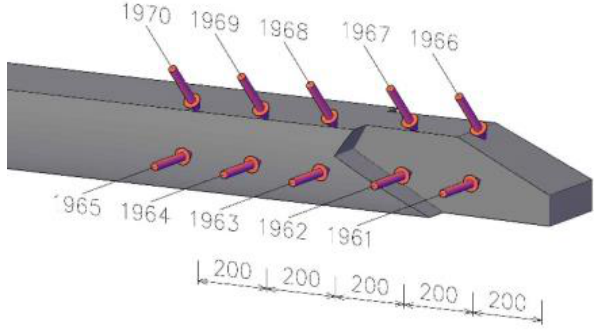
Figure 12. Marking of the points measured by Resistograph, beam (H2).